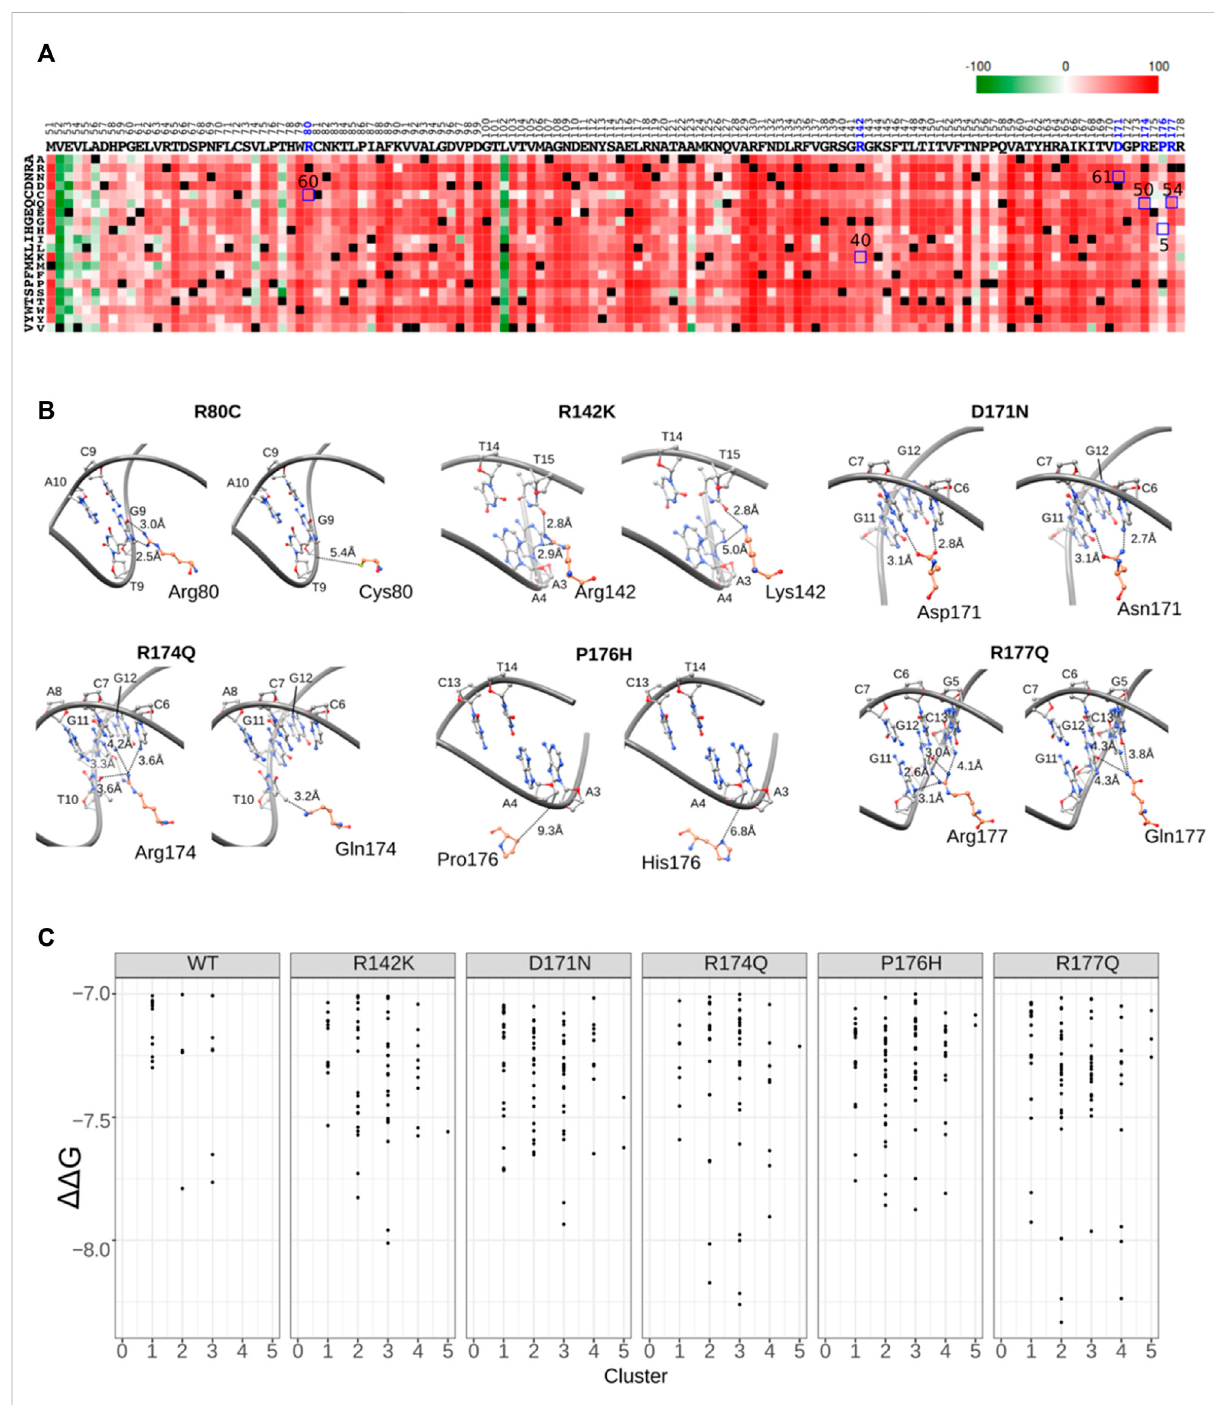
FIGURE 5 Mutation functional probability and DNA proximity. (A) Heatmap showing mutants ’ probability of an impact upon functionality. Green color indicates lesser predicted impact while red color indicates higher impact. The x axis shows all amino acids of the RUNX1 DNA binding domain while the y axis shows the probability of mutation to each individual amino acid. Highlighted blue square boxes showing mutation probability scores for selected mutation represented in Figure 5B. (B) Cancer-associated missense mutation effect on molecular interactions, with the modeled and calculateddistancebetweenresiduesshownbydottedlines.DNAisshownasagrayribbonandallresiduesarerepresentedbyballandstickmodels. (C) ComparativedockingoftheAMLassociateddrugmoleculeenasidenibwithcancer-associatedmutationsofRUNX1R142K,D171N,R174Q,P176H and R177Q versus wild type